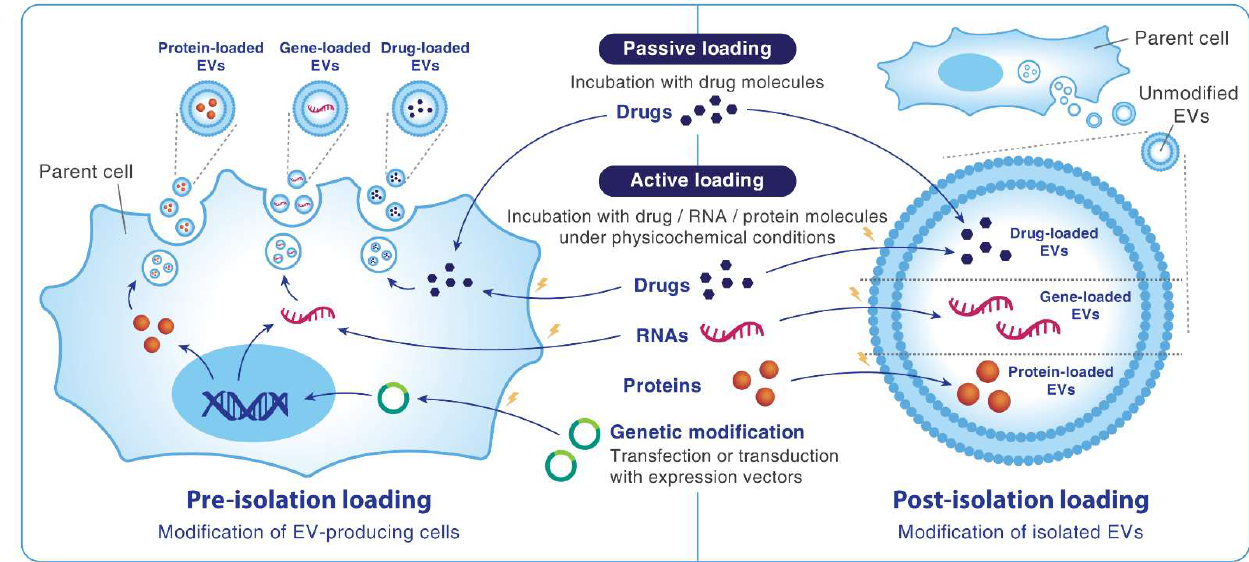
Figure 1. Methods of cargo loading into extracellular vesicles. EVs, extracellular